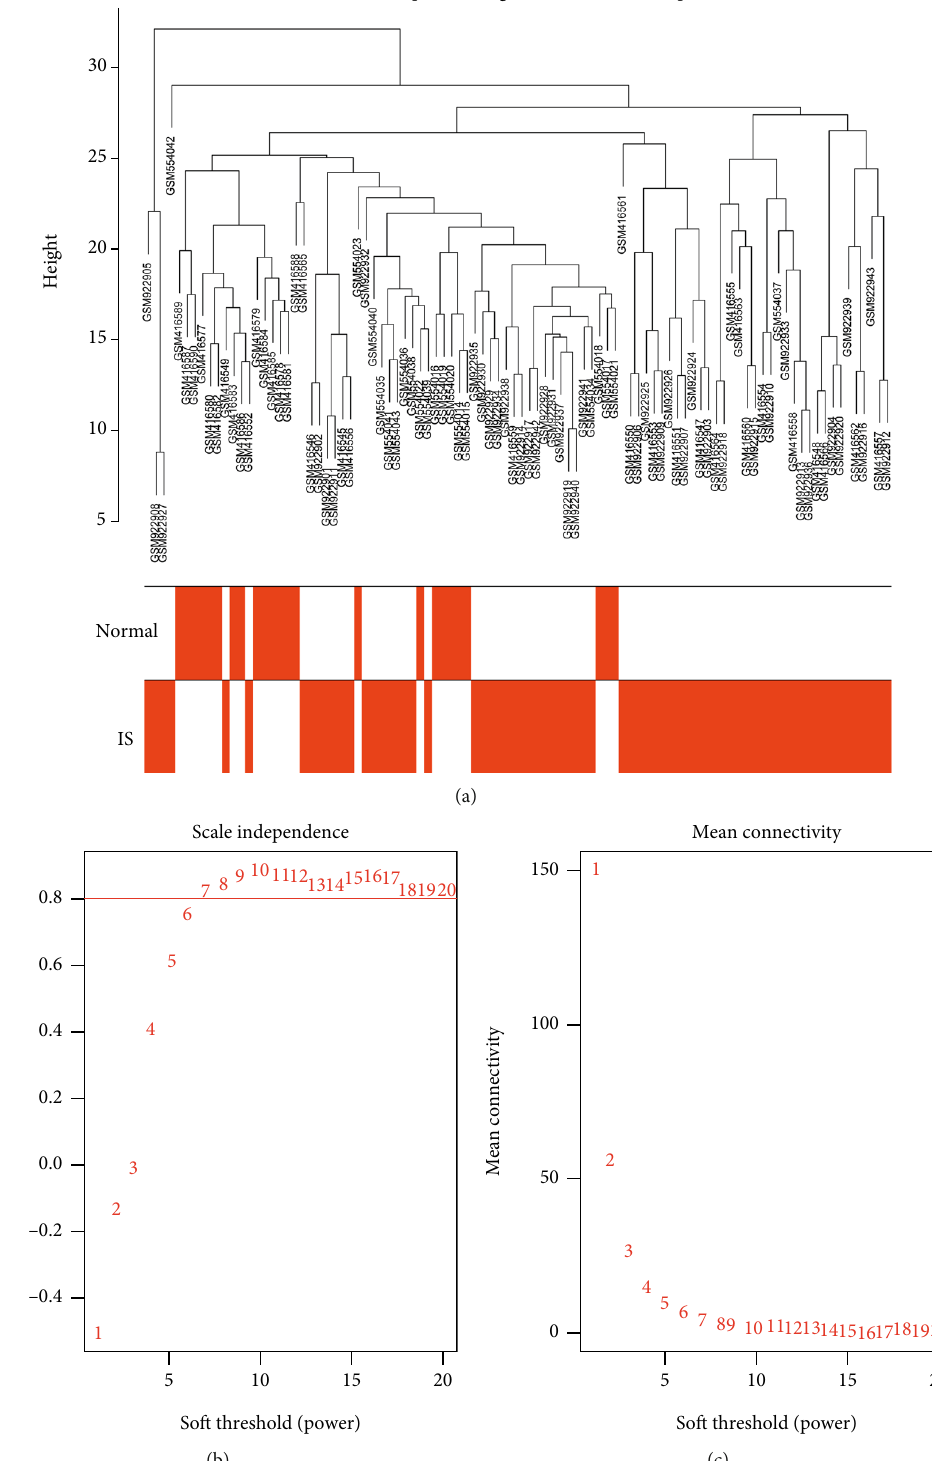
Figure 2: Construction and module division of the co-expression network. (a) Cluster tree diagram of the sample. The cluster tree re fl ects the distance between 96 samples. (b) Soft threshold ( R ^2 ) determination; the fi tting degree R ^2 increases with an increase in the soft threshold. When the fi tting degree R ^2 > 0 : 8 (red line), the corresponding network is more consistent with the scale-free network distribution. (c) Soft threshold selection (average